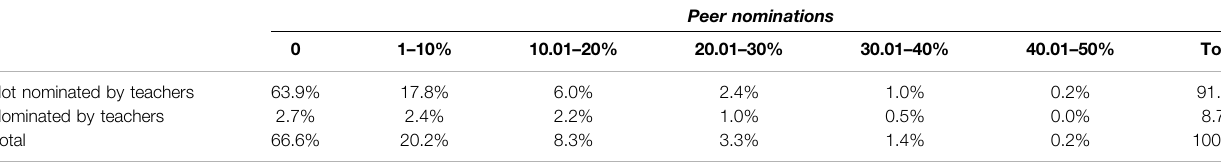
TABLE 2 | Distribution of nominations for relational bullying in percentages.